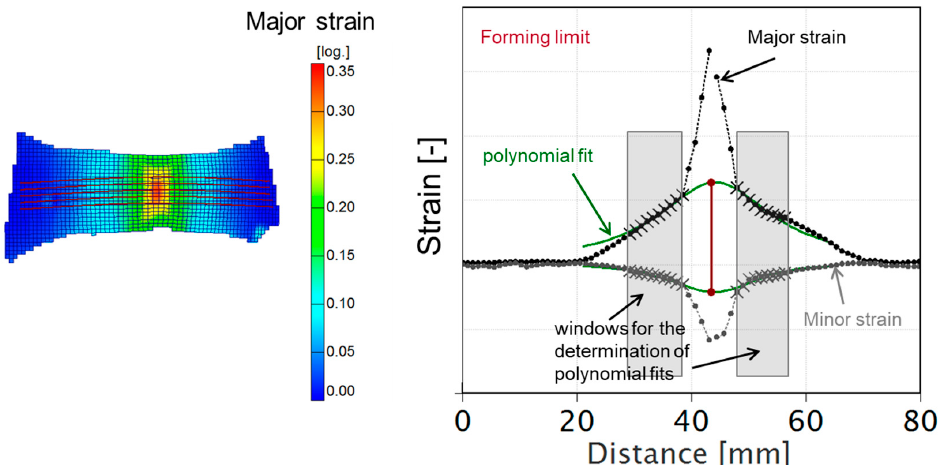
Figure 5. Evaluation of the forming limit according to the section line method proposed in DIN EN ISO 12004-2 [19]. On the left-hand side, the 3D-Aramis major strain field with the positioning of the section lines in the last image before fracture can be seen. The diagram on the right-hand side shows the evaluated forming limit with the major and the minor strain over the position in the